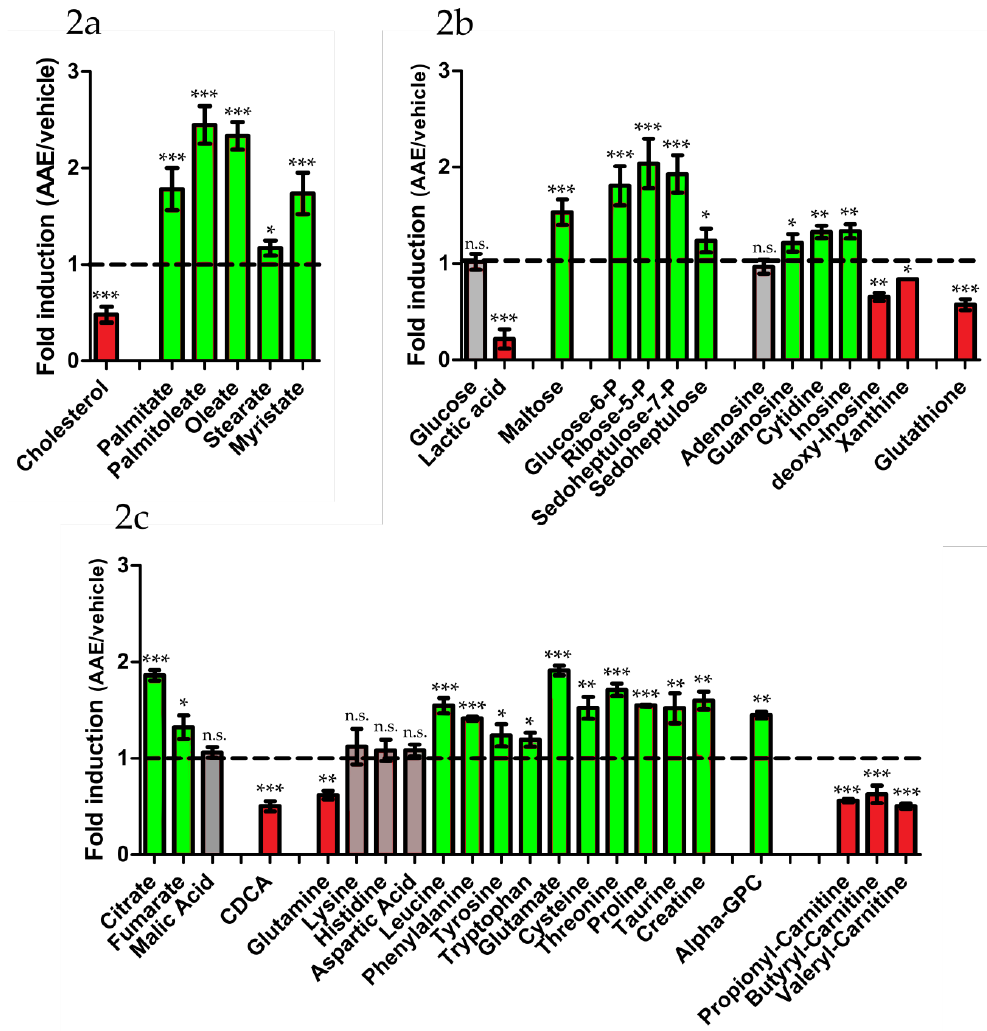
Figure 2. AAE diverts HuH7 metabolism from lactic fermentation toward mitochondrial respiration. Metabolomic profiling of HuH7 cells grown for 72 h in the presence of AAE (400 mg/L). Each bar represents the fold change (AAE versus vehicle) in the intracellular concentration of the indicated metabolites ( n = 5 measurements, Shown is mean ± SEM Two way ANOVA and Bonferroni post test analysis were performed; *** p < 0.001; ** p < 0.01; * p < 0.05; n.s. non statistically different). Colors are used to highlight increased (green), reduced (red) and unaltered (gray) intracellular metabolites. (CDCA, chenodeoxycholic acid; alpha-GPC, glyceryl phosphoryl choline)) To prove that the treatment with Annurca polyphenols was indeed increasing mitochondrial activity, we used the mitochondrial probe Mito Tracker CMX-ROS. The fluorescence emitted by this